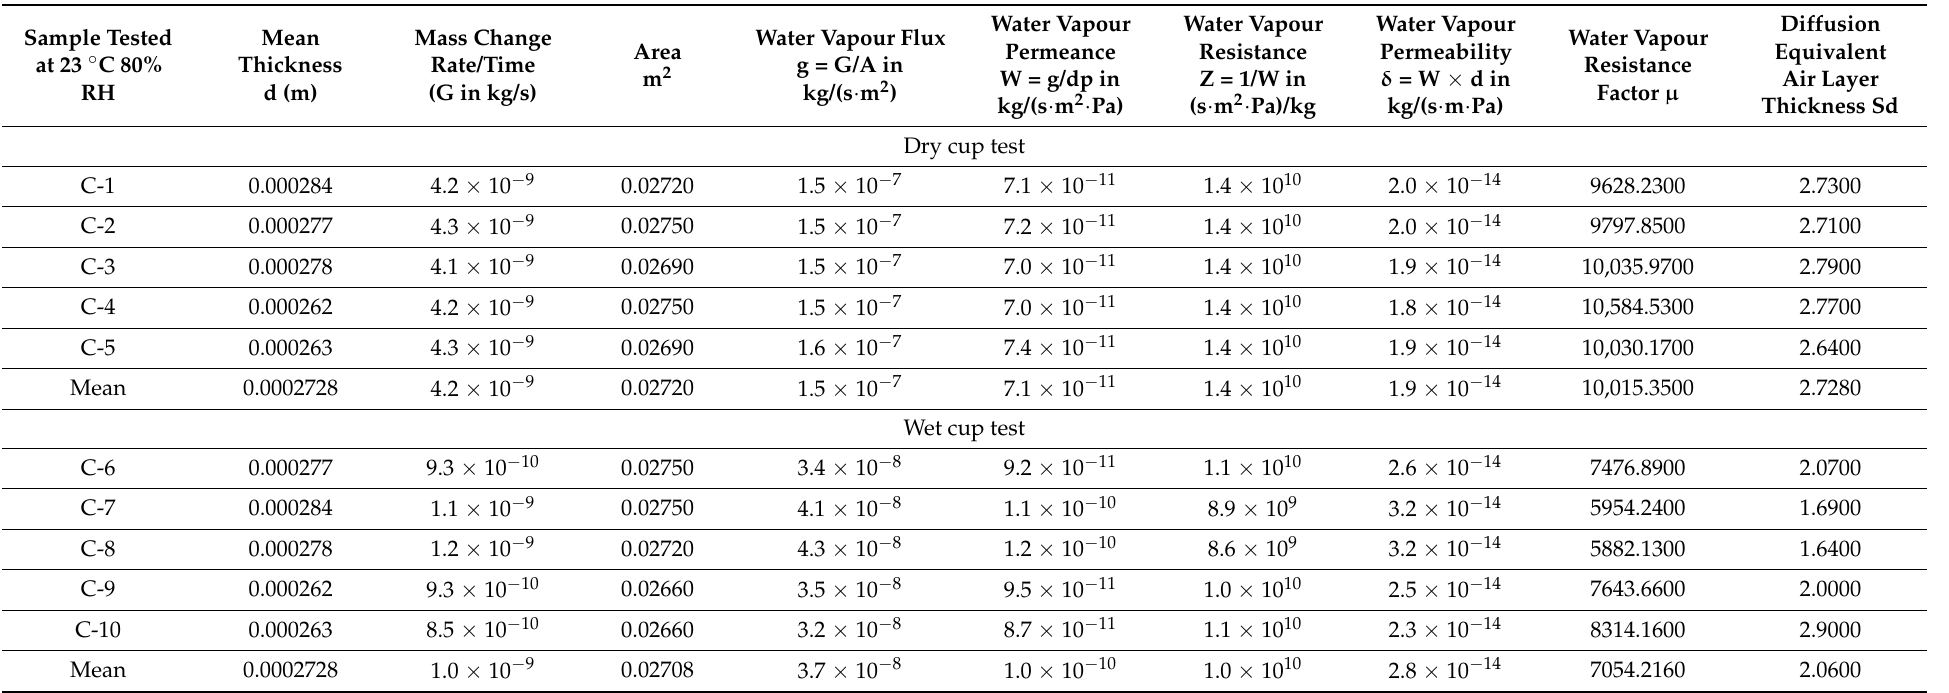
Table A5. Water vapour resistivity properties of sample C at 23 ◦ C 80%